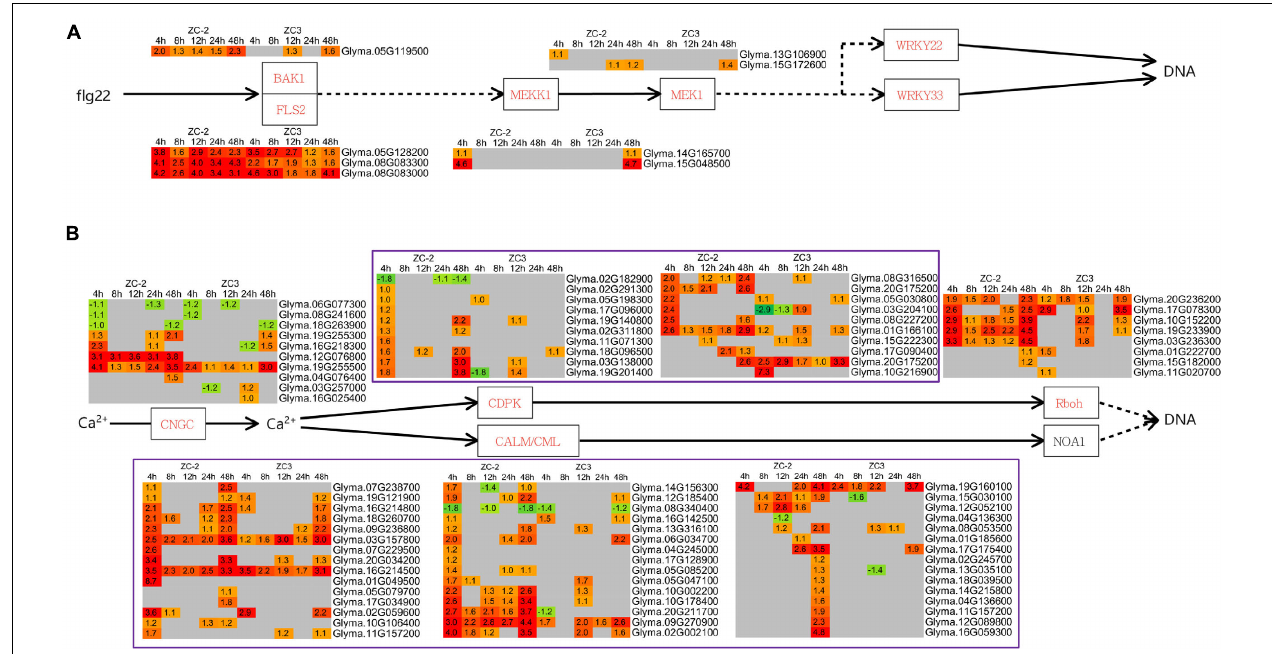
FIGURE 7 | Schematic diagram of MAPK and Ca 2 + signaling pathways together with heatmaps of the associated differentially expressed genes (DEGs). (A) MAPK signaling pathway; (B) Ca 2 + signaling pathway. The log 2 expression fold change is color-coded in each box: red indicates up-regulated DEGs and green indicates down-regulated DEGs. Each row represents a DEG with its gene ID; the columns represent each sampling time point [4, 8, 12, 24, and 48 h post-inoculation (HPI)] for ZC-2 and